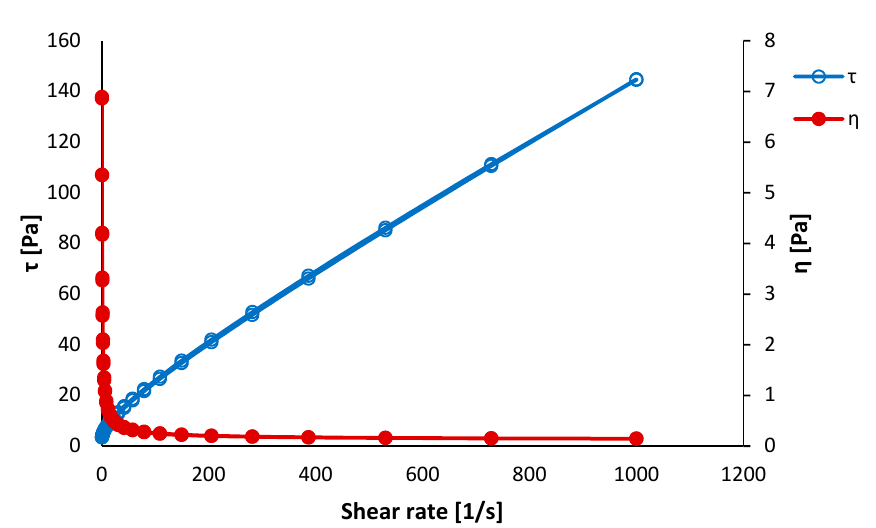
Figure 4. Dynamic viscosity measurement of a polycaprolactone/hydroxyapatite precursor after 5 h of the preparation.